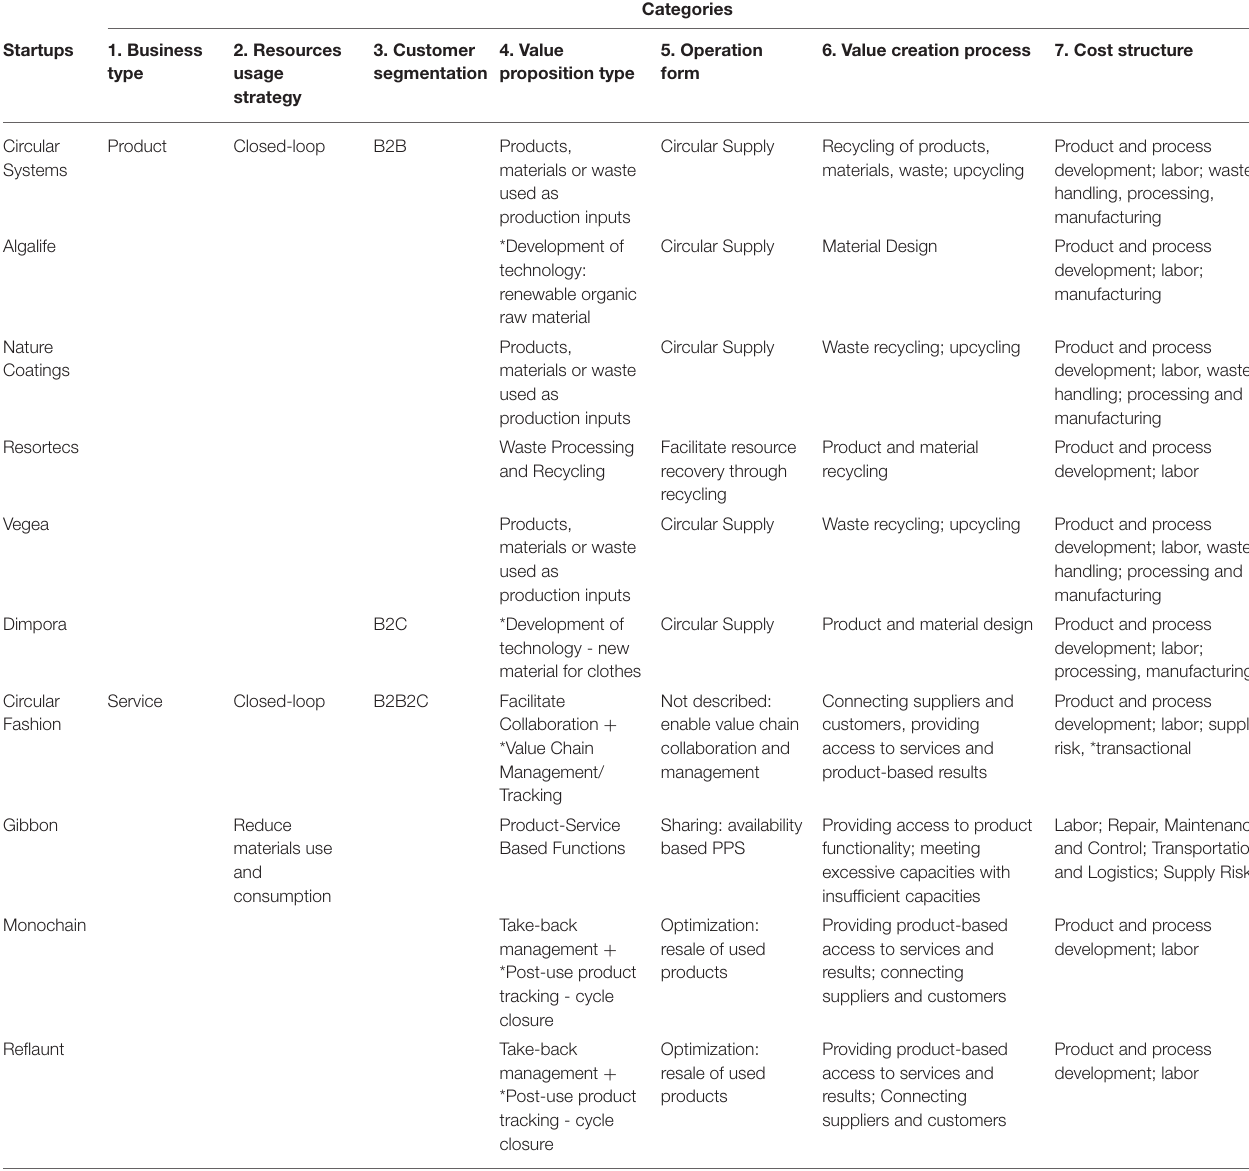
TABLE 3 | Results from fashion startups’ BMI4CE